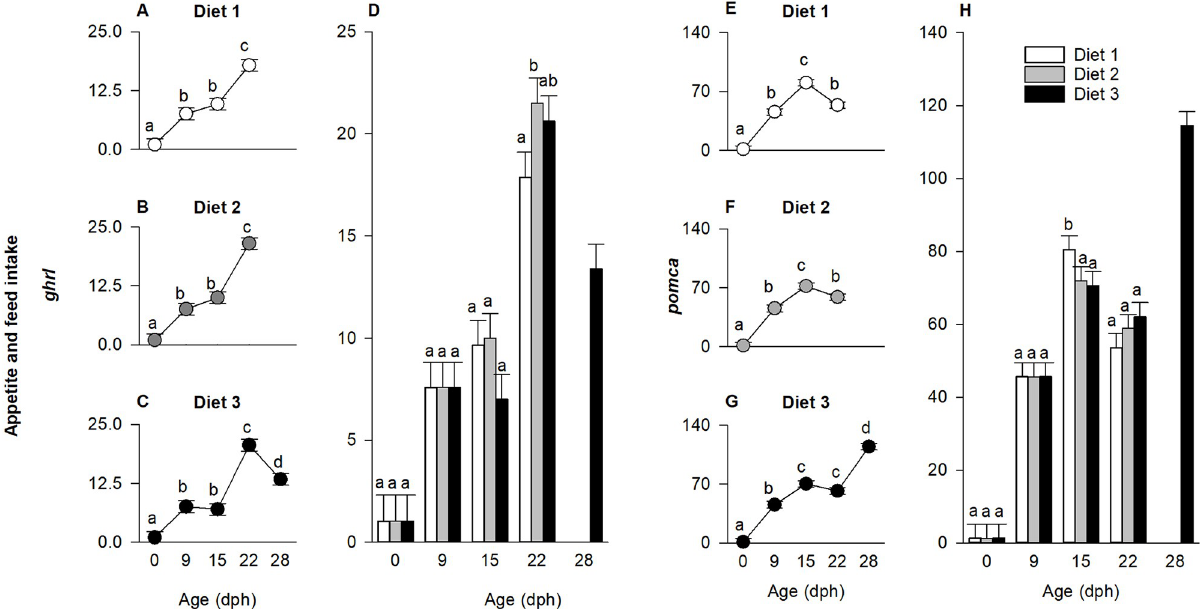
Fig 6. Effect of age (days post hatch (dph)) and treatment (diet) on relative expression of ghrelin ( ghlr ) and proopiomelanocortin ( pomca ) in European eel, Anguilla anguilla , larvae. Values represent means ( ± SEM), while different lower-case letters represent significant differences (p < 0.05).